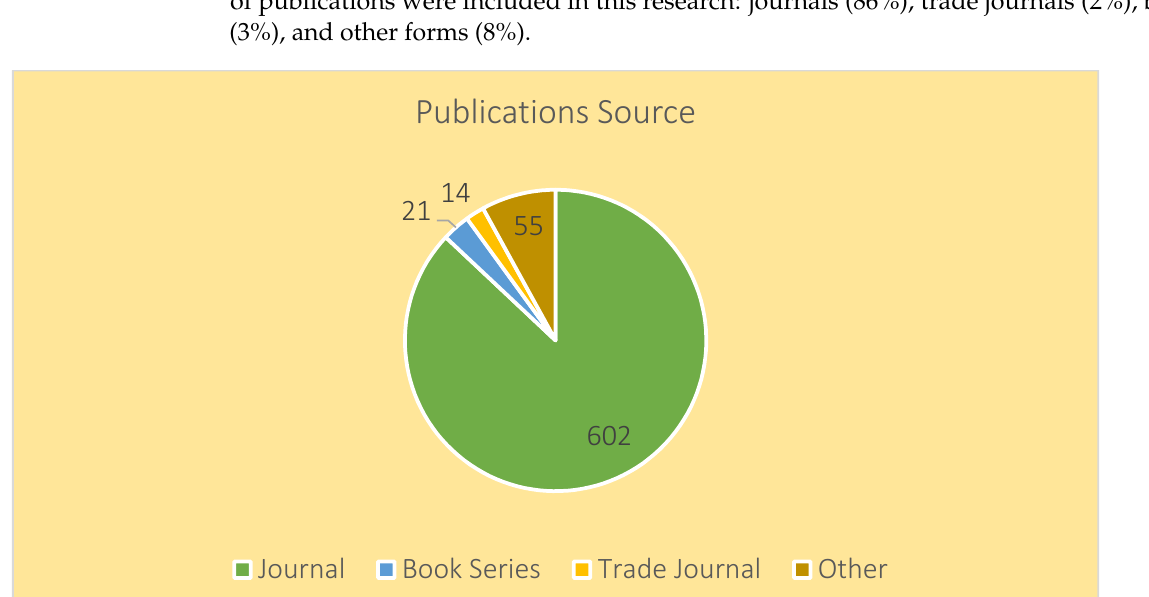
Figure 5. Publication Distribution by Country. 3.4. Keywording Strategy Considering the aforementioned exclusion criteria, the following string was used to narrow the results: (“blockchain” AND “construction” AND “management”) OR